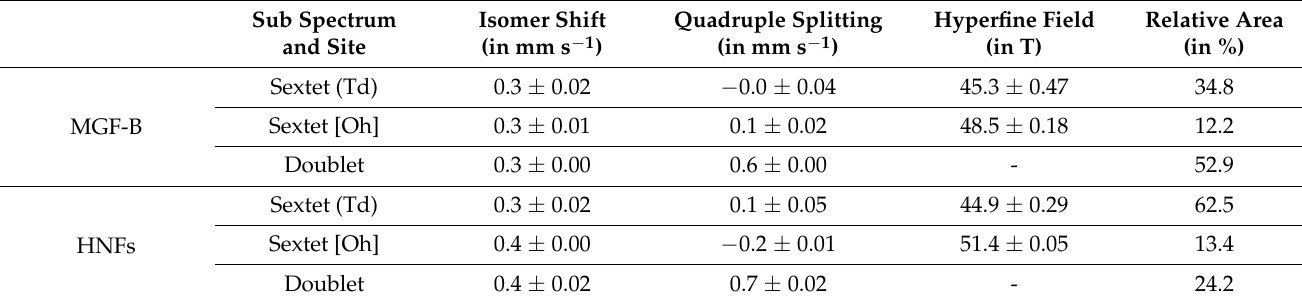
Table 3. Mössbauer parameters of magnesium ferrite-bentonite (MGF-B) and Hierarchical nanoflowers (HNFs).